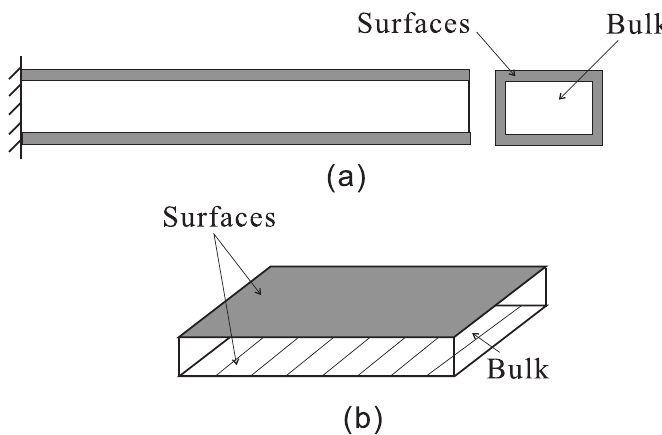
Figure 1. Schematic of ( a ) a piezoelectric nanobeam; and ( b ) a piezoelectric nanoplate with surface